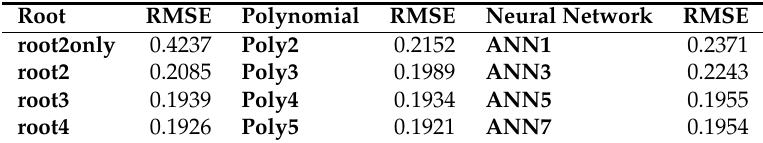
Table 3. Root mean squared error of all fitting methods (inclusive).